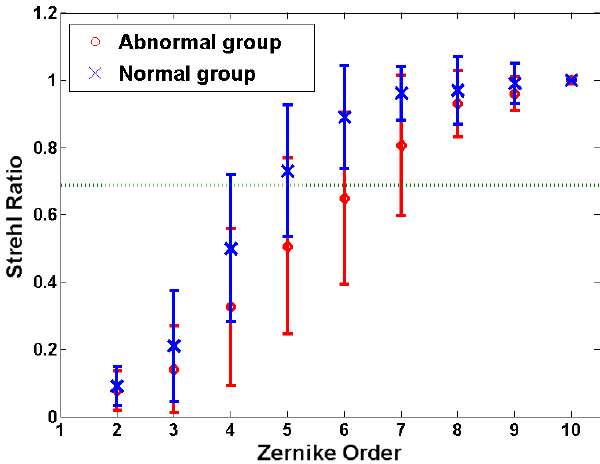
Fig. 4. SR as a function of correction for Zernike order in normal and abnormal group. Mean values were shown by the symbols. The error bars in this ¯gure indicated (cid:1) 2 standard deviations from the mean. Horizontal dashed line corresponds to SR for the di®raction limit.